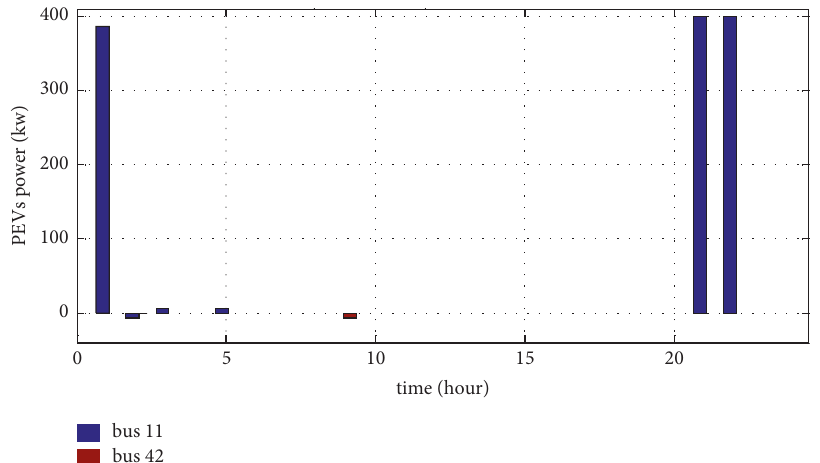
Figure 18: Charge/discharge power of PEV fleet 1 in case 3 (the first scenario).